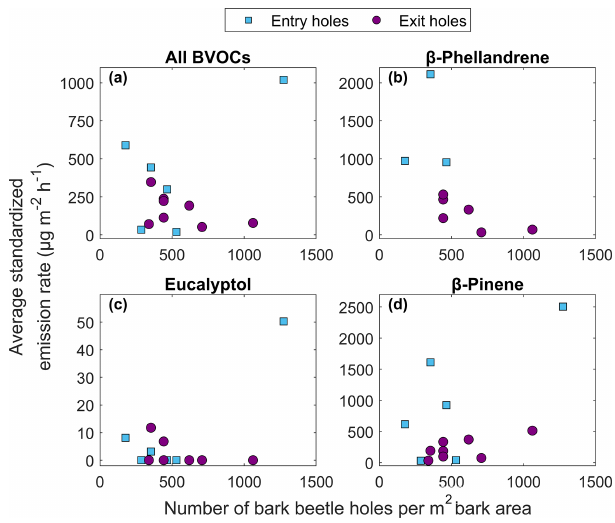
Figure 9. The relationship between average temperature standard- ized emission rate from infested Norway spruce trees in Hyltemossa and Norunda and the number of bark beetle holes per square meter bark area for (a) the average of all BVOCs, (b) β -phellandrene, (c) eucalyptol and (d) β -pinene. The bark beetle holes are separated into entry holes (blue squares) and exit holes (purple